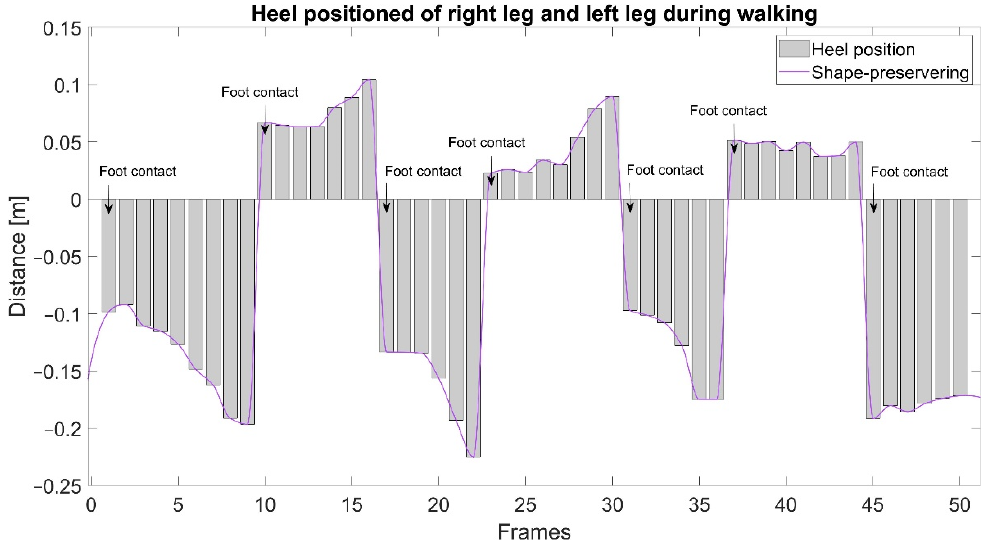
Figure 7. Heel estimation from both the right and left legs. During walking, the laser projection from the LiDAR device onto the lower leg of the subjects generates a round shape. These round shapes are the contours of the back of the subject’s heel, as shown in Figure 8. As the subject walks towards the end of the walking distance, the clarity of the cloud points decreased. Therefore, in order to increase the ac- curacy of the heel estimation, we fitted a 4th-order polynomial for each LiDAR scanning frame, as shown in Figure 9a,b.